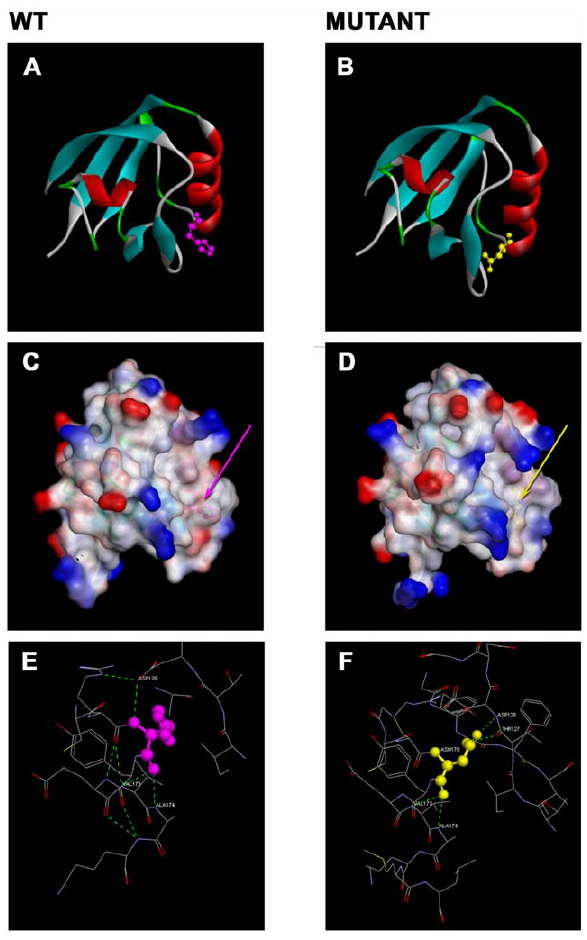
Figure 4. Diagrams of structural models for GIPC3. The ribbon diagrams for the 3D models of the PDZ domain in GIPC3. The wild type (A) and the mutated p.H170N (B) forms are shown. The key for structural features follow; the a -helices (red); the b -strands (blue); the b - turns (green); the loops (light gray); the side-chain for H170 in the wild type (pink) and the side-chain for N170 highlights the mutation (yellow). The surface diagrams show the surface topology and the interpolated charge distribution of the PDZ domain of GIPC3. Both the wild type (C) and the mutated p.H170N protein (D) are provided. The p.H170N mutated form shows one of the substrate molecular recognition pockets as being deeper with a larger volume compared to the wild type. The p.H170N mutated form shows the interpolated charge distribution as being reduced compared with the wild type. Structural and local environment for position 170 with the H-bond patterns are shown. The GIPC3 wild type (E) shows an absence of side- chain to main-chain H-bonds with the H170 side-chain; whilst the asparagine side-chain (yellow) in the mutated protein (F) forms side- chain to main-chain